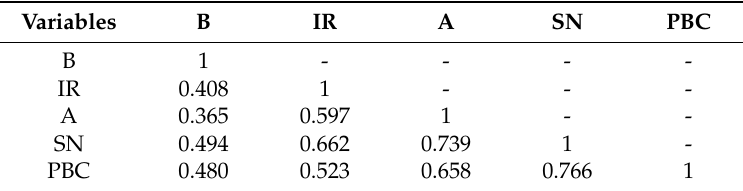
Table A3. Correlation values between latent